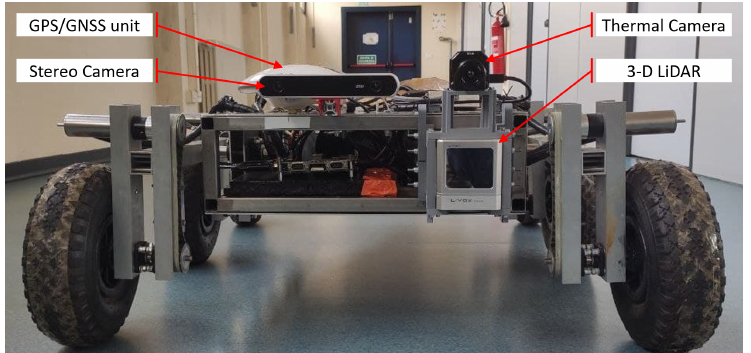
Figure 6. Instruments installed on board the MORPHEUS rover [30] when the proposed thermal mapping algorithm was tested outdoors. The 3D printed mounting structure, supporting the thermal camera and the LiDAR, was secured to the front of the rover’s frame (on the right), together with a Swift Navigation GPS/GNSS unit and a StereoLabs ZED binocular RGB stereo camera (on the left).